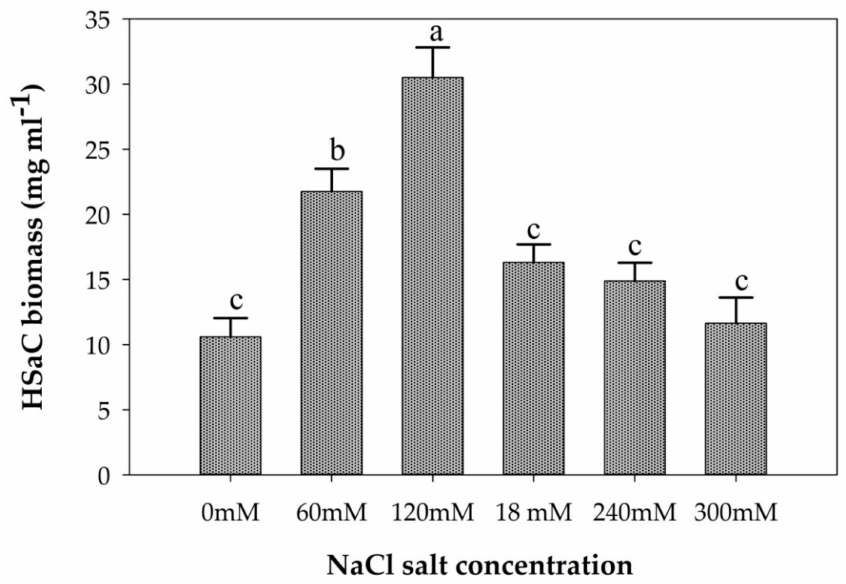
Figure 1. Cyanobacterial strain HSaC biomass (mg / mL) in di ff erent NaCl salt concentrations (0 mM, 60 mM, 120 mM, 180 mM, 240 mM and 300 mM). The error bars represent standard deviation (SD). The data are the mean of the three replicates. Di ff ering letters indicate significant di ff erences in the means of HSaC cyanobacterial biomass in pair-wise comparisons (Tukey’s test p < 0.05) for each treatment by LSD.